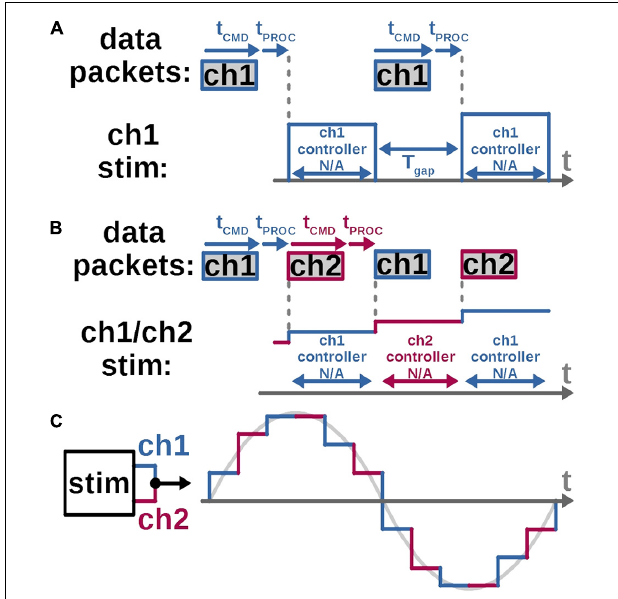
FIGURE 4 | A continuous, gapless arbitrary stimulation waveform is created by interleaving two stimulation channels for each electrode. (A) A gap between stimulus pulses arises while using the custom SoC (Lo et al., 2016) adopted for this work, as each channel’s local controller is unable to receive parameters of the next stimulus pulse, while outputting the current one. Thus, SoC ch1’s local controller can accept a new command only after ch1 completes its current output pulse. The resulting gap between current and next pulses equals command length plus command-processing time. (B) While ch1 output is in progress, a command is sent and accepted at ch2’s controller, which sets up and fires the next pulse without the gap. (C) Arbitrary continuous waveform at each stimulation electrode can be created by connecting it to the output of two channels on the stimulator and assigning odd and even waveform samples to each respective channel.